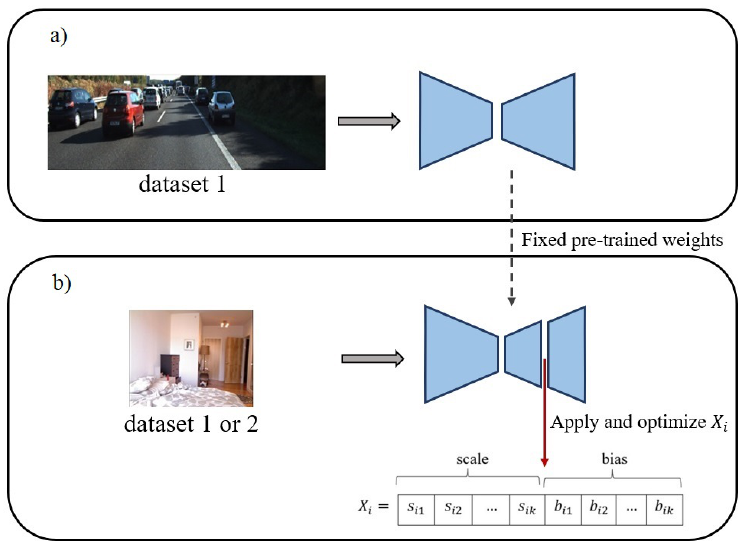
Figure 1. Overall performance of the proposed scheme: ( a ) Train on dataset 1, ( b ) inference on the same or another dataset. Keeping the pre-trained weights fixed, channel-wise scales and biases are applied to an intermediate activation map and are optimized to improve the predictions for the input dataset. The input dataset can be identical to the training dataset or a new